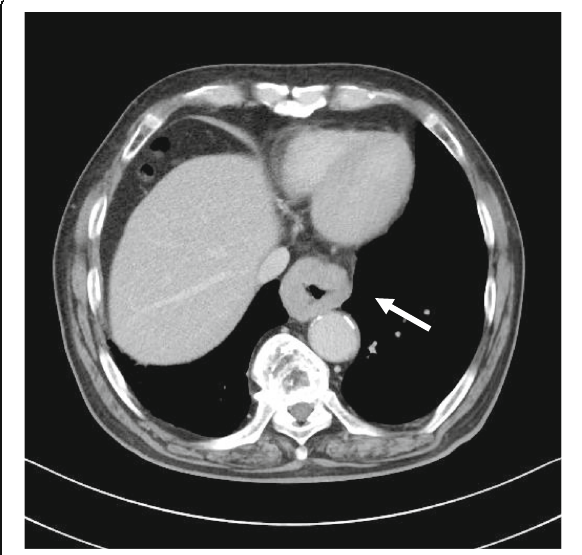
Fig. 4 Computed tomography (CT) of the thorax revealed wall thickening from the lower thoracic esophagus to the abdominal esophagus